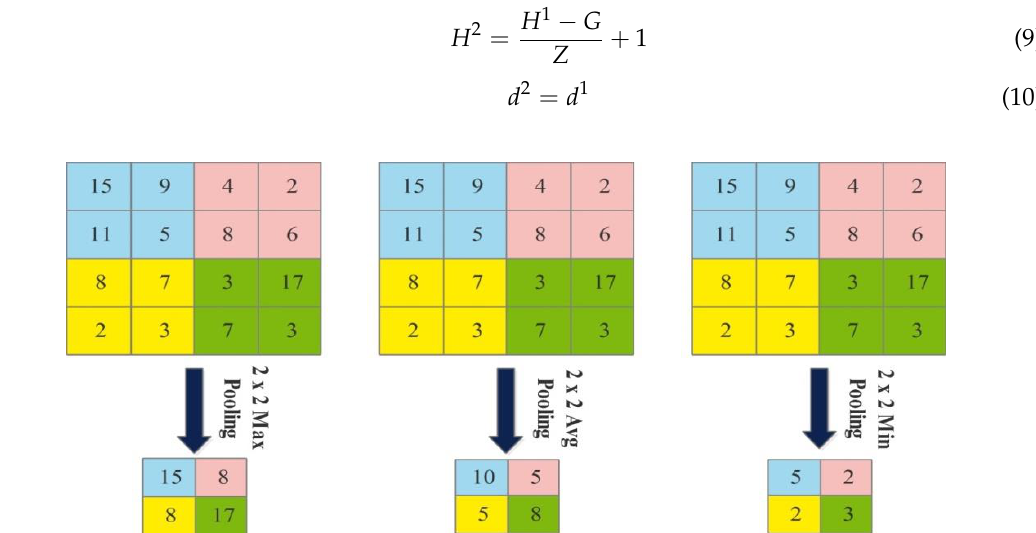
Figure 5. An example of max pooling, average pooling, and min pooling. The fully connected layer (FC) comprises neurons fully linked with all preceding layers of activations. After that, the activations can be calculated using matrix multiplication and bias offset. Finally, the performance of this layer is graded using the SoftMax classifier. Mathematically it is defined as: